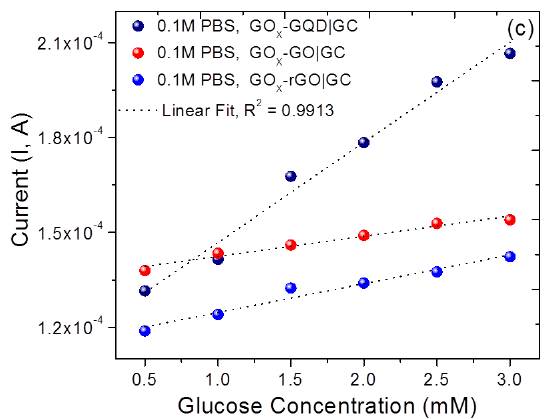
Figure 5. ( a ) Cyclic voltammograms; ( b ) DPV profiles; and ( c ) variation of peak current with varying glucose concentration (0.5, 1, 1.5, 2.0, 2.5 and 3 mM) for GO x –GQD|GC. The CV profile with glucose is measured at 20 mV/s scan rate. All of the potentials are with respect to the Ag/AgCl reference electrode.